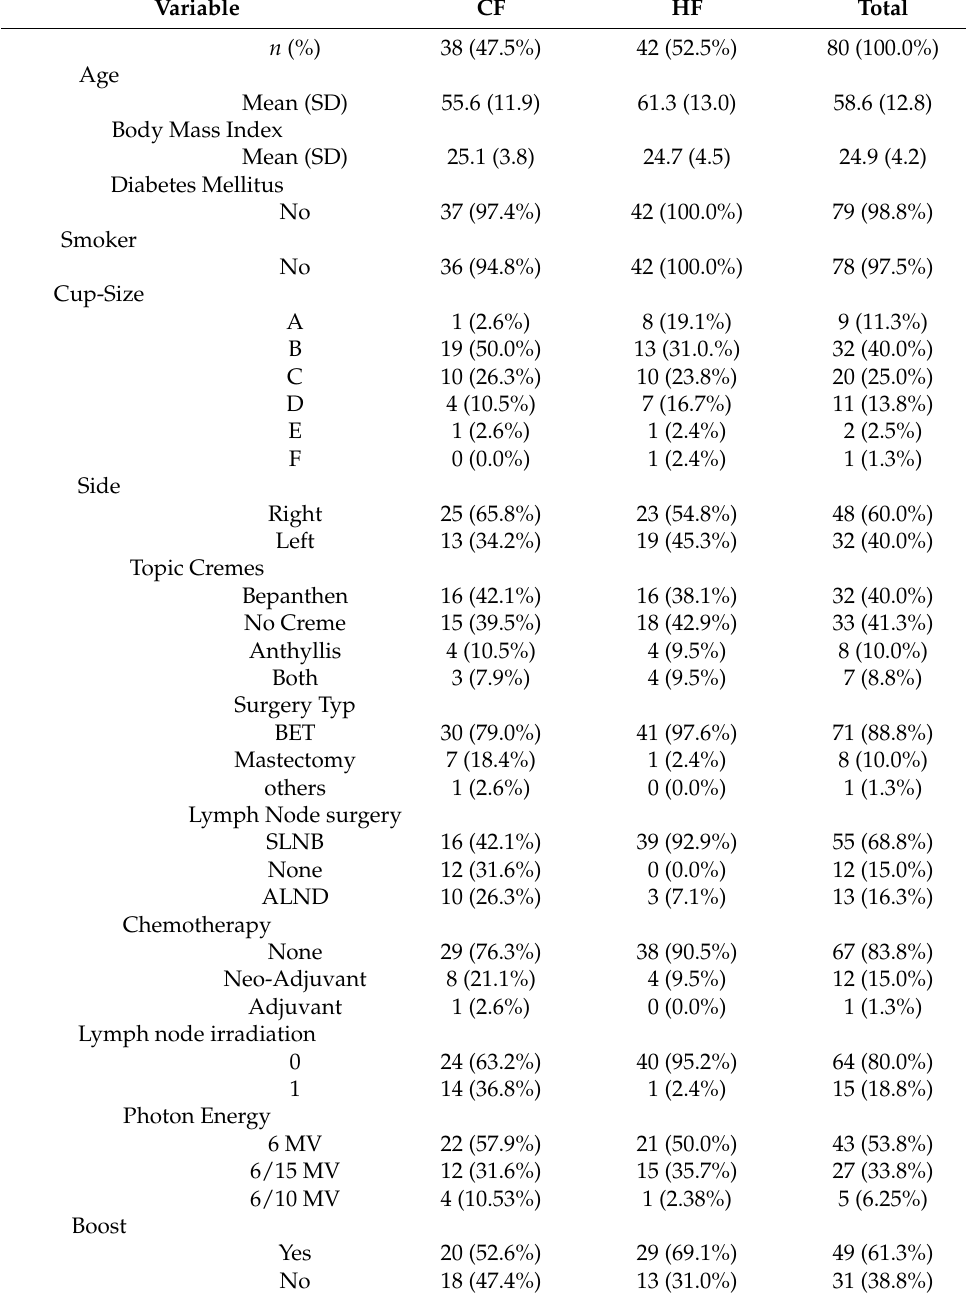
Table 1. Patients’ characteristics after hierarchical clustering. Missing values account for deviations from 100% in same